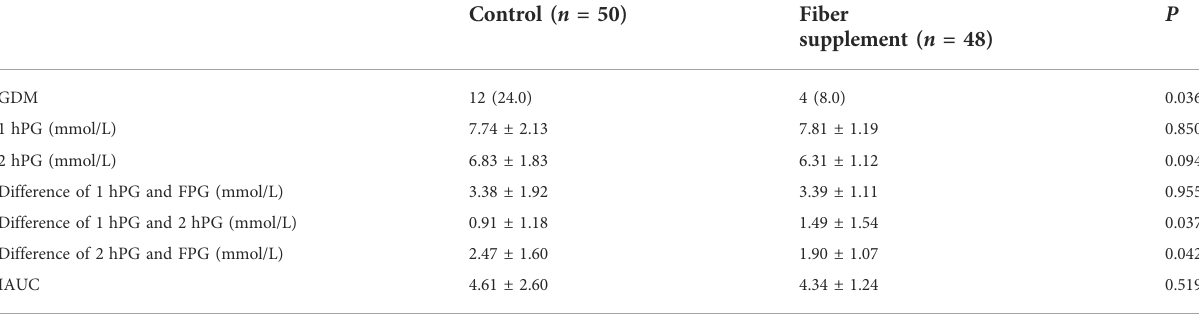
TABLE 3 Comparison of OGTT between the two groups post